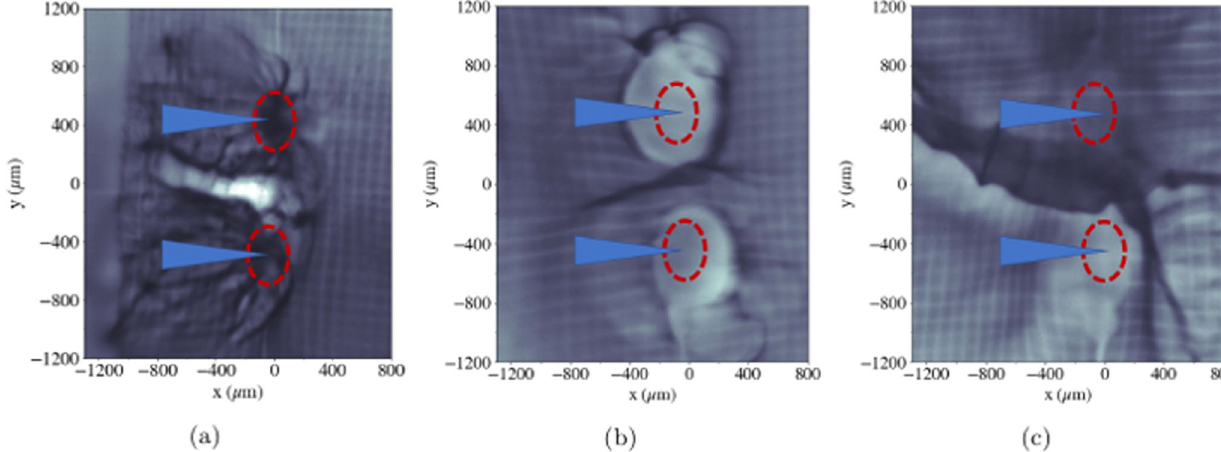
Fig. 3 Proton radiographs from probing at 45° to the target normal. Radiographs of the interaction using 17.4 MeV protons probing at 1 ns for ( a ) and ( b ) and at 2.5 ns for ( c ). The protons probe the interaction at 45° to the target normal with the protons probing through from the same side as the main laser ( a ) and from the opposite side ( b ) and ( c ). In these images (blue) lasers are incident from the left onto the targets, noted by red